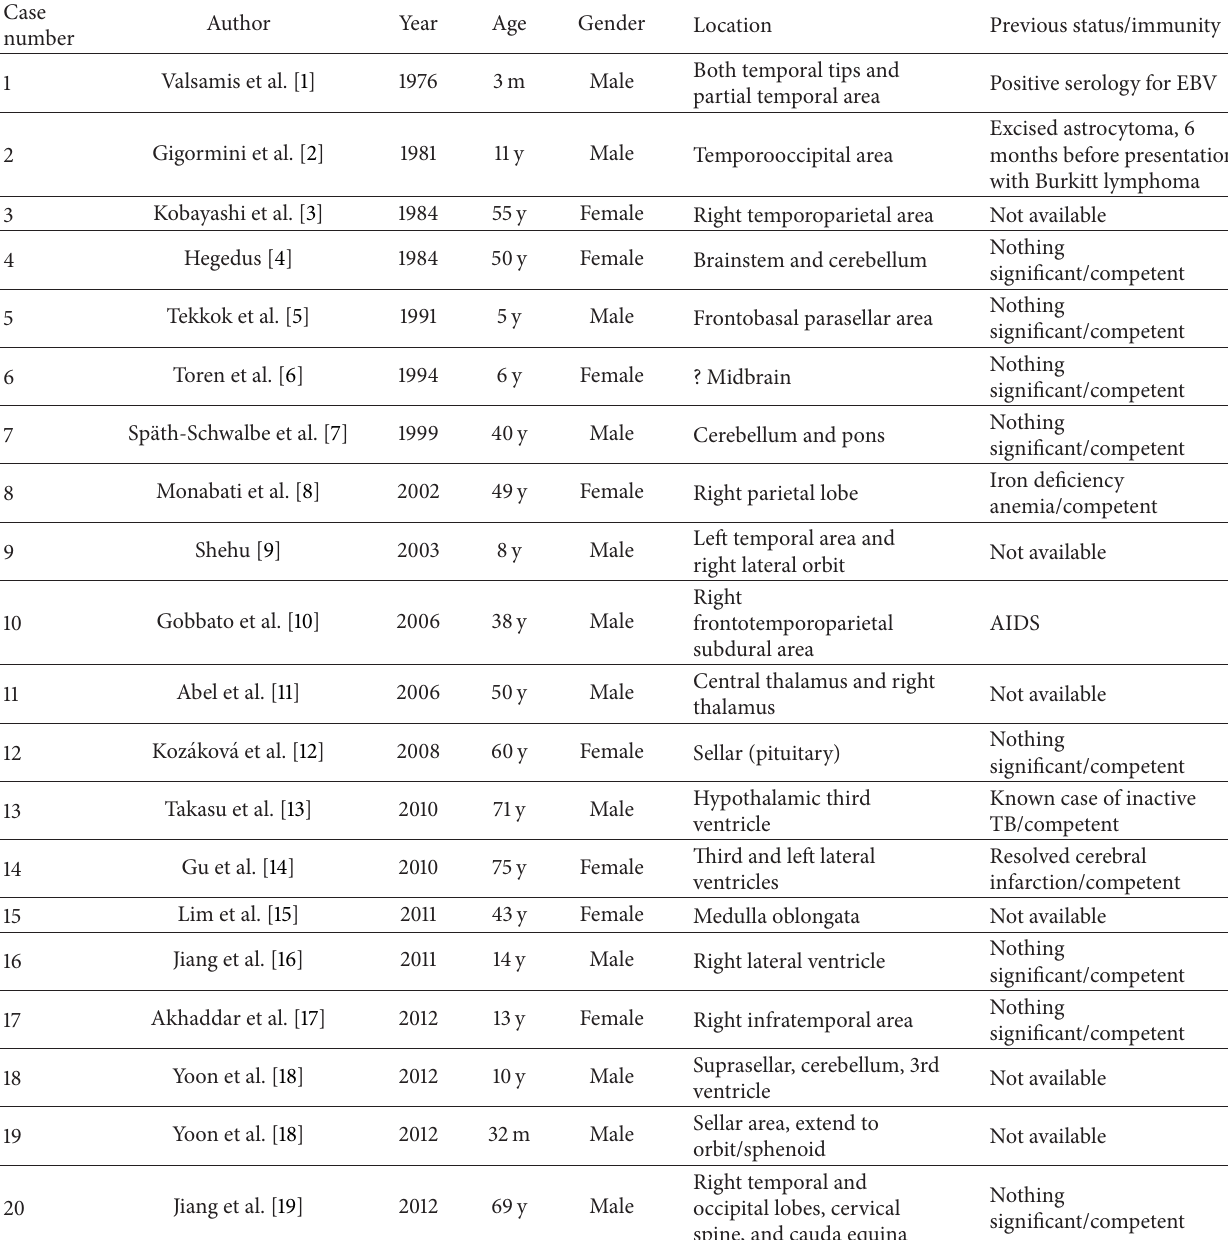
Table 1: Reported cases of primary Burkitt lymphoma in central nervous